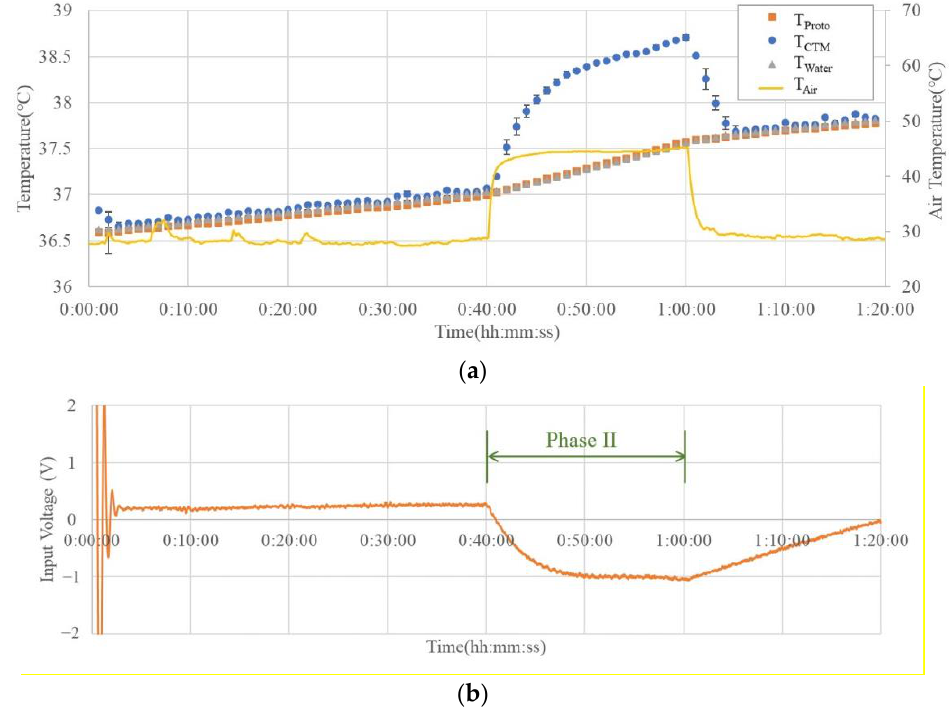
Figure 6. ( a ) Example of the results of simulator experiment showing the temperature change and ( b ) overtime change of Peltier module input voltage (V Input ).